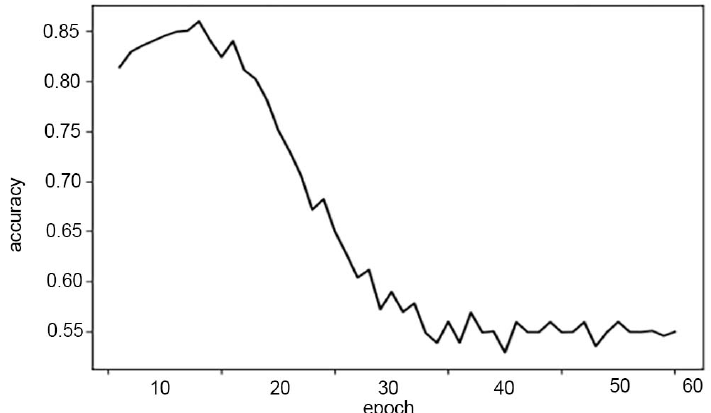
Figure 7. The accuracy of the discriminator during the confrontation training process changes with the number of confrontations.